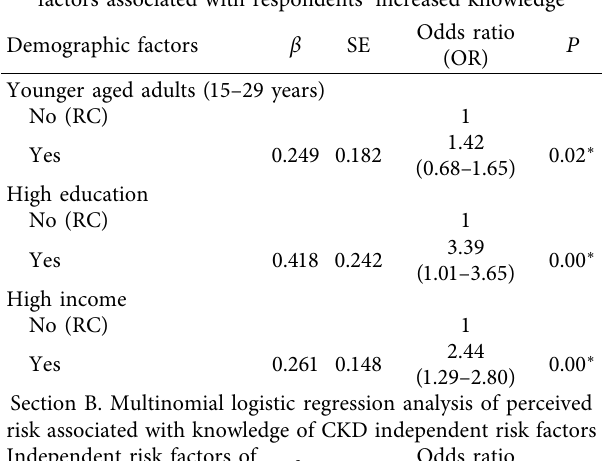
Section B. Multinomial logistic regression analysis of perceived risk associated with knowledge of CKD independent risk factors